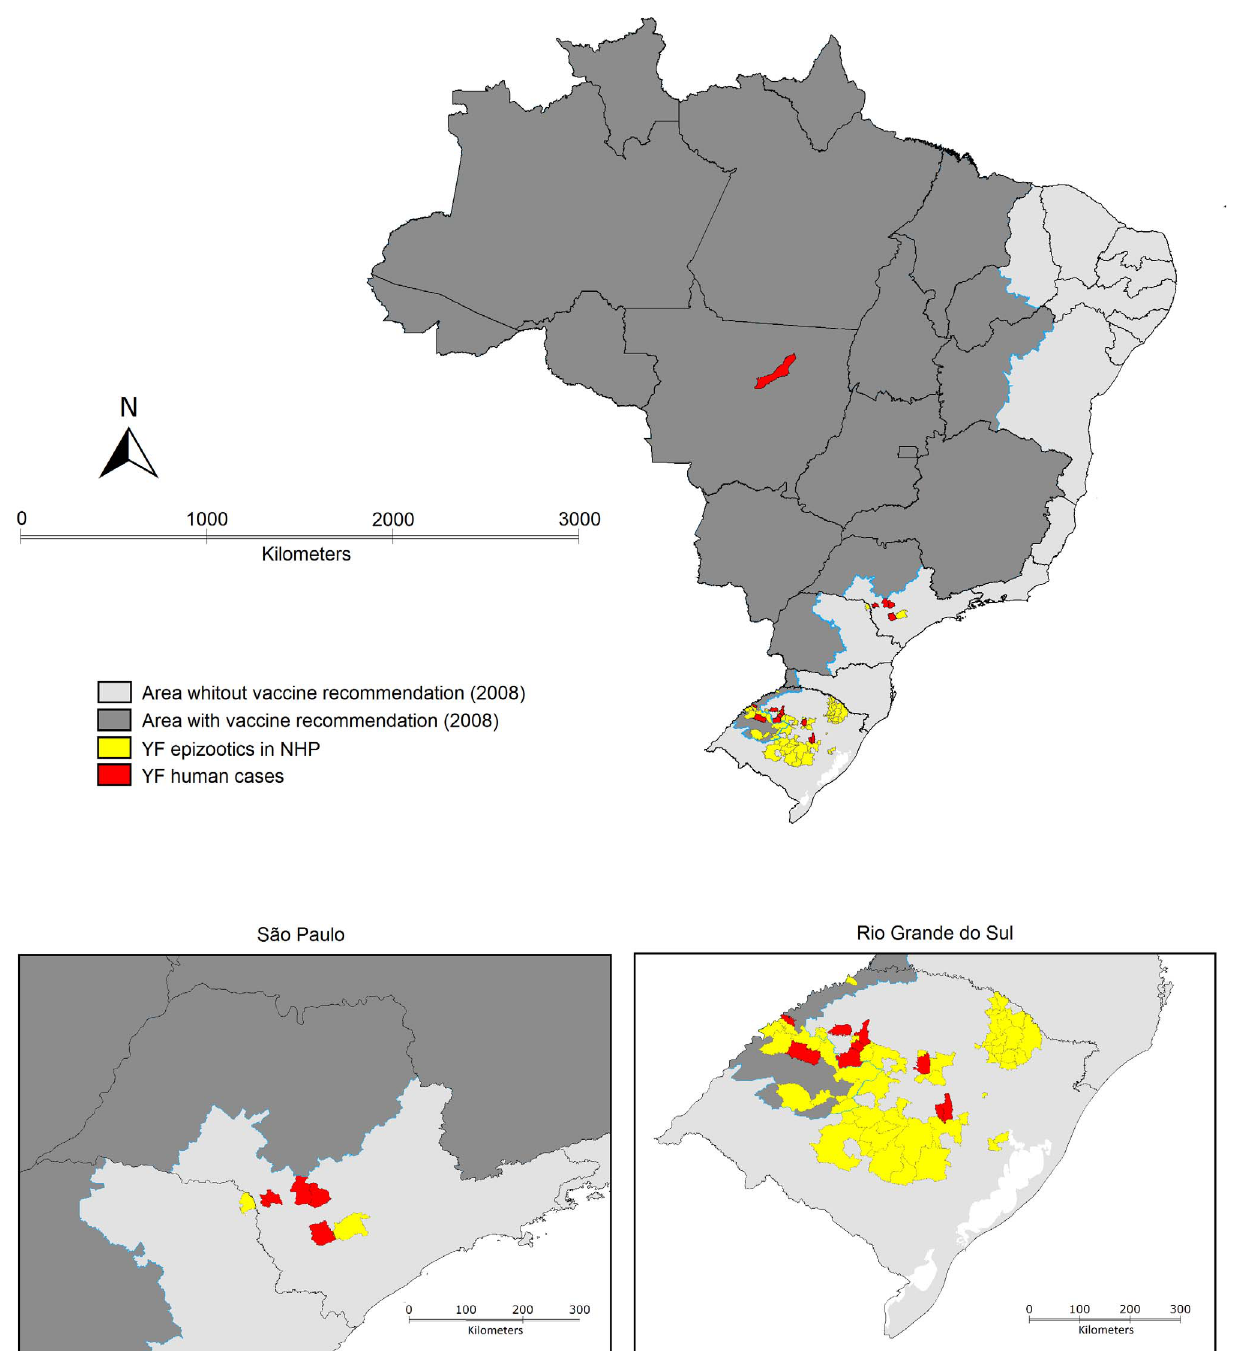
Figure 2. Location of confirmed epizootic events and human cases of yellow fever, Brazil, 2008–2009 (insets: states of Sa˜o Paulo and Rio Grande do Sul). doi:10.1371/journal.pntd.0002740.g002 Rates of vaccine-associated viscerotropic disease in the three states that reported cases ranged from 0.4 to 1.6 cases per million doses administered (Table 2). Among the 45 confirmed cases of yellow fever vaccine-associated acute neurologic disease, median age was 21 years (range 22 days - 66 years) with 26 (58%) cases among males. Rates of neurologic disease in the three states ranged from 0.8 per million doses administered in Santa Catarina to 11.0 per